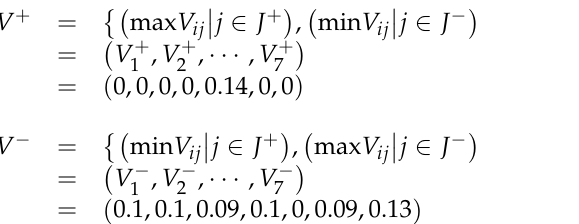
Figure 10. Factor data characteristics. Determine the positive and negative ideal solution. The positive ideal solution plane is formed by the maximum value in matrix V of the benefit factors and the minimum value in matrix V of the cost factor from all alternative routes. The negative ideal solution plane is formed by the minimum value in matrix V of the benefit factors and the maximum value in matrix V of the cost factor from all alternative